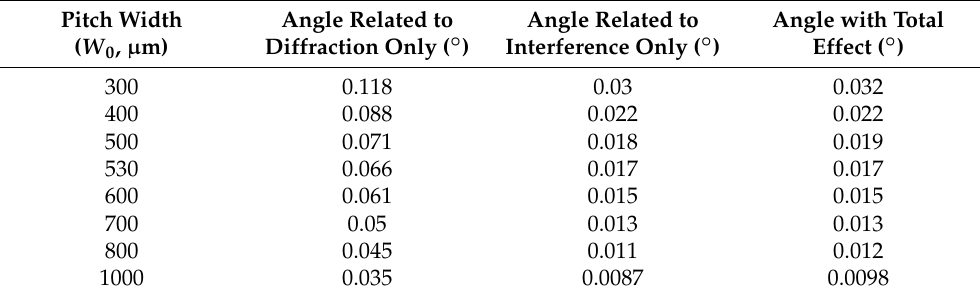
Angle with Total Effect ( ◦ )